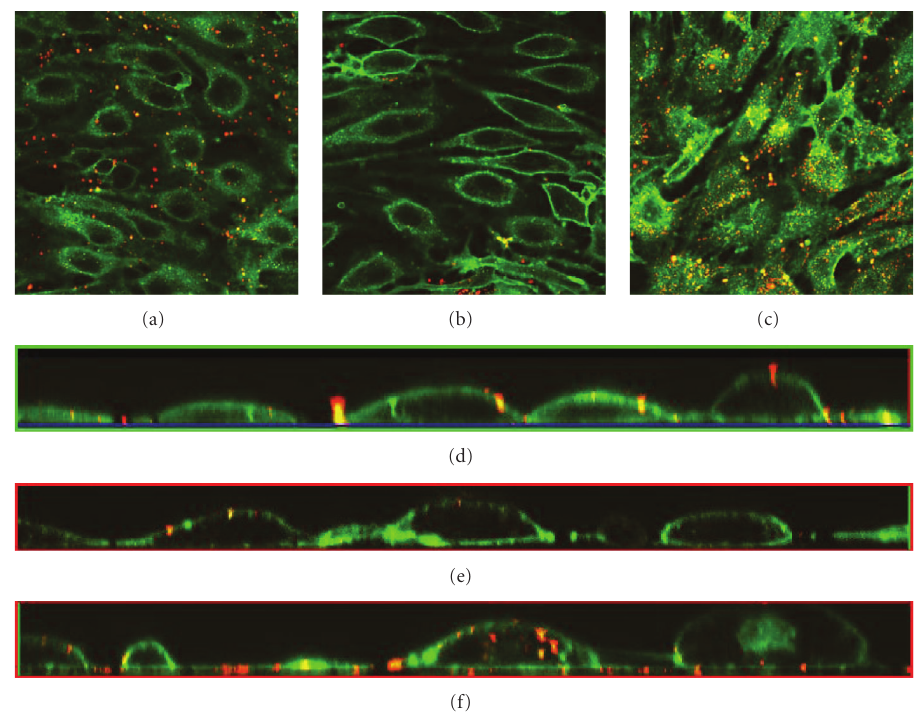
Figure 5: Flow e ff ects on the glycocalyx layer and uptake of LDL. PAEC incubated with LDL after exposure to di ff erent conditions of flow. The glycocalyx layer is visualized under the confocal microscope through staining of heparan sulfate with FITC-conjugated lectin (green) and LDL added as DiI complex (red) after di ff erent times in culture. (a) Cells exposed to flow shear stress for 24 hours, (b) 48 hours, and (c) cells grown under static conditions for 24 hours. Internalized LDL appears yellow when colocalized with heparan sulfate stain. (d) Cross- section from the image stacks created with confocal microscopy of the stack (a), (e) cross-section from the side of the stack (b), and (f) cross-sections from the side of the stack